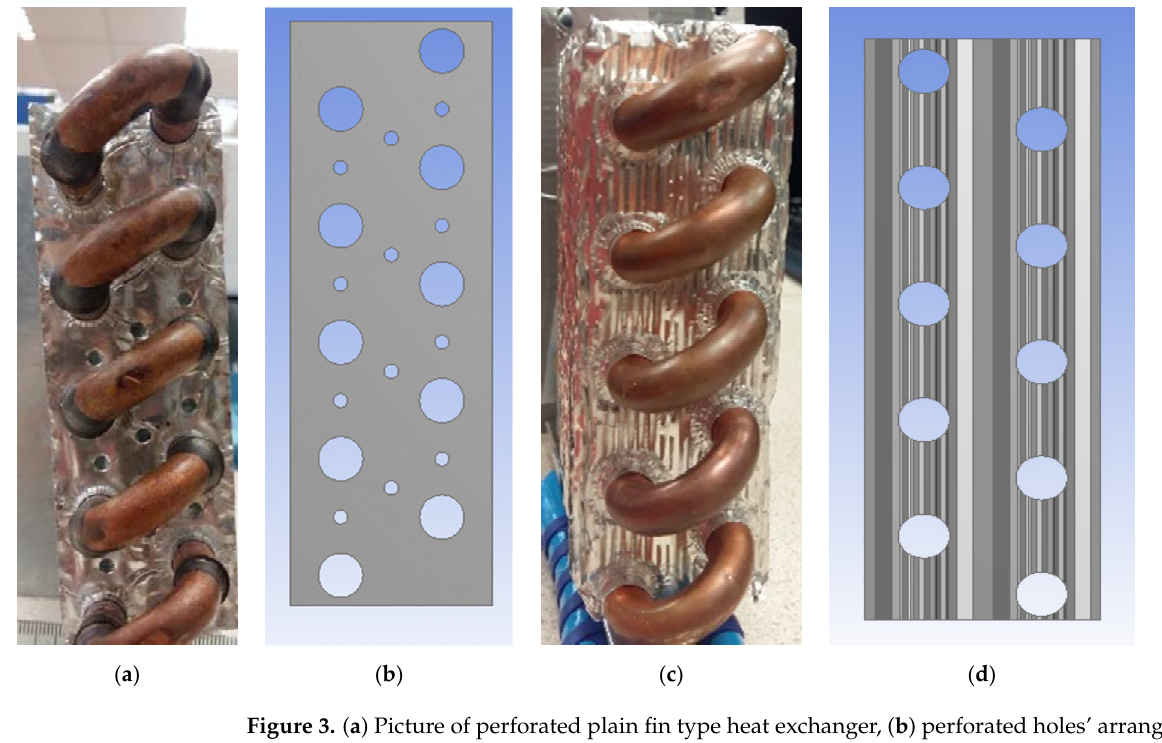
Figure 3. ( a ) Picture of perforated plain fin type heat exchanger, ( b ) perforated holes’ arrangement, ( c ) louvred fins heat exchanger, ( d ) louvred fin shape.